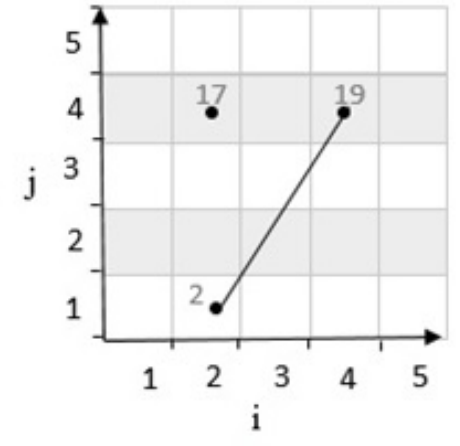
Figure 4. Position of a point with positive